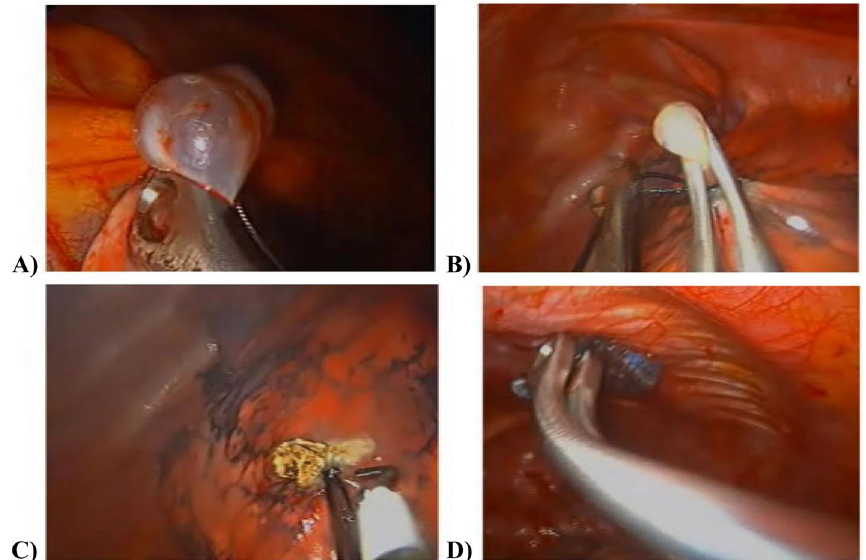
Fig. 1 VATS bulla ligation technique:‑. A Grasping bulla by lung grasping forceps. B Advancing a silk suture (size 1) below the clamp and ligate the silk suture by knot Pusher. Another silk suture can be ligated below the first for confirmation. C Cauterize the bulla by hook diathermy. D Apical pleural abrasion for pleurodesis via diathermy scratch pad over a long